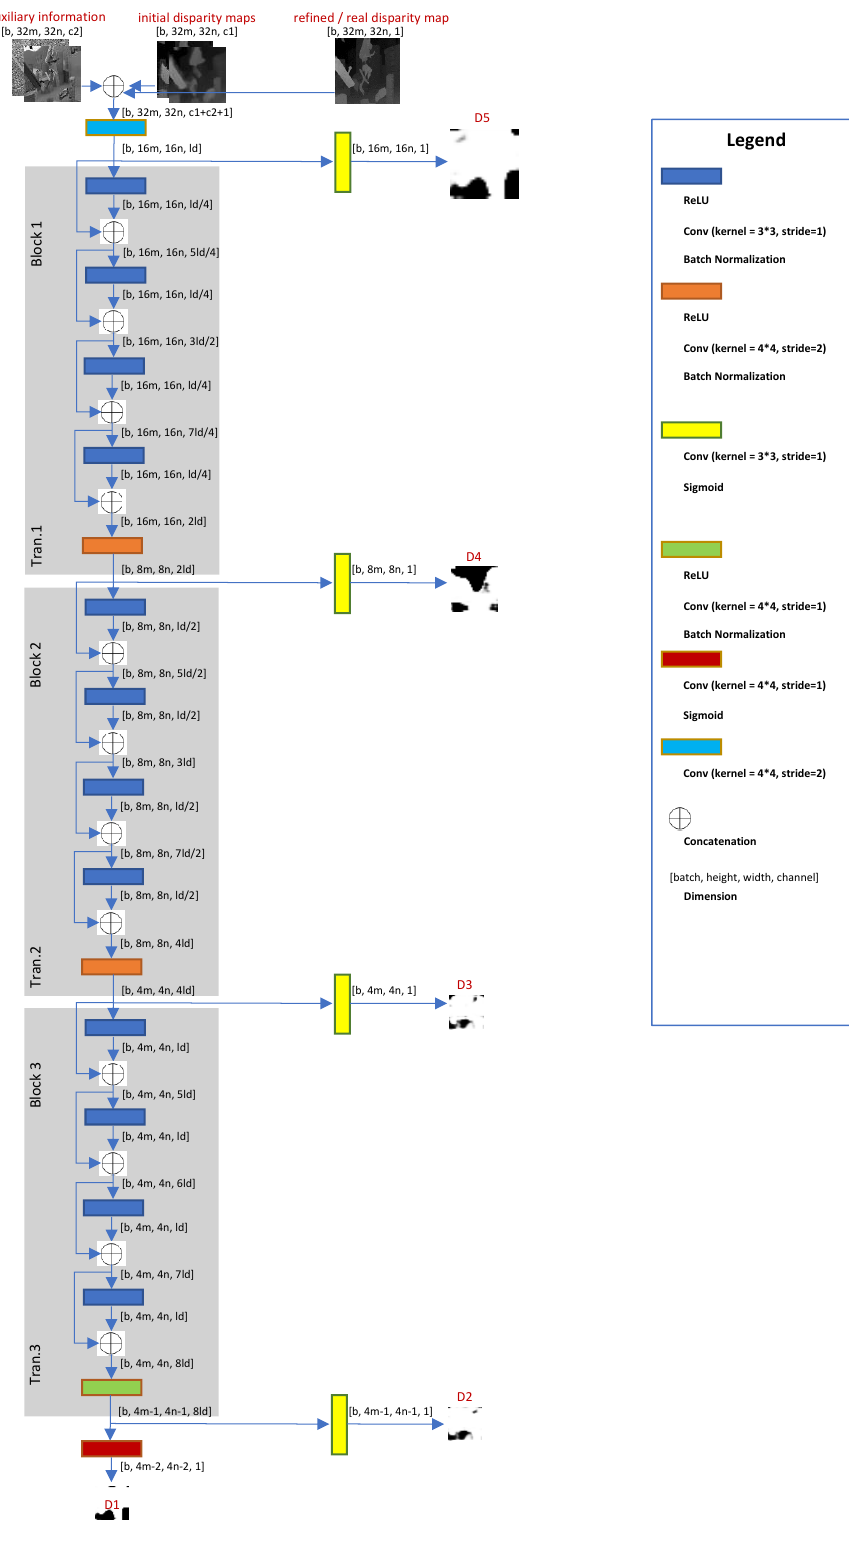
Figure 3. This figure shows some important hyperparameters and the discriminator architecture configuration. Please refer to Table 2 for the specific values in each